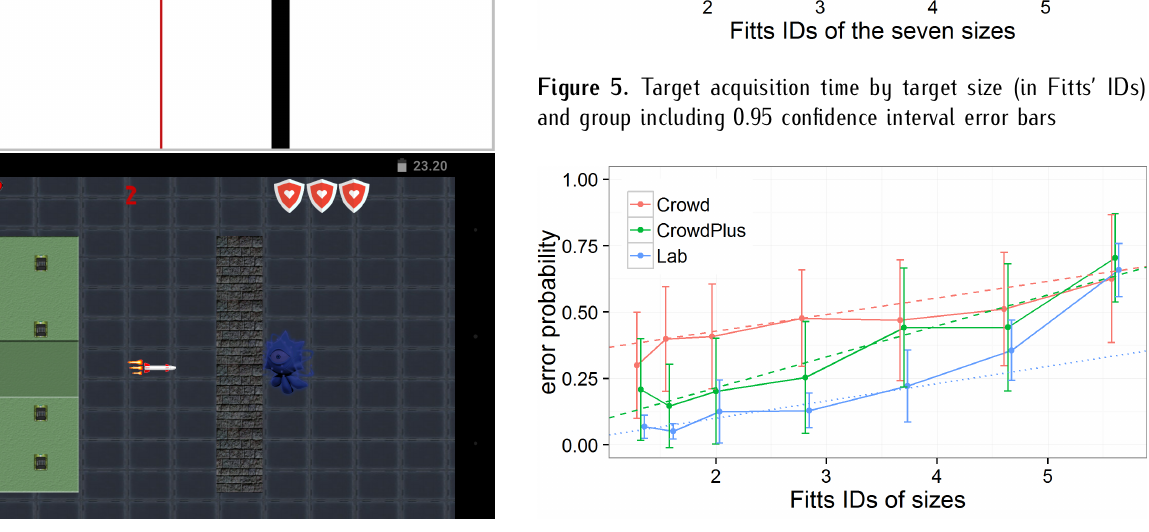
Figure 4. Design of the standard DHR test (top) and the gamified version (bottom) with the starting area in green, no indication of the pointer but the missile as feedback on successful drag actions on the targets (wall)